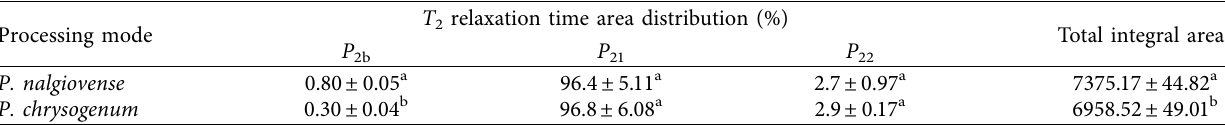
Table 2: Water populations of three components (b) in fermented chicken